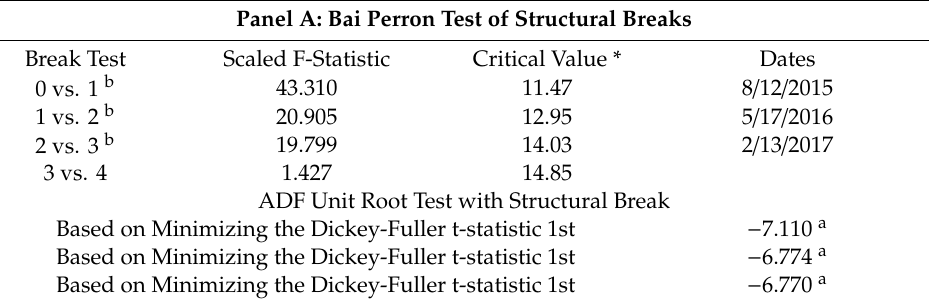
Table 1. Break points, diagnostics, and summary 24 June 2013–24 July